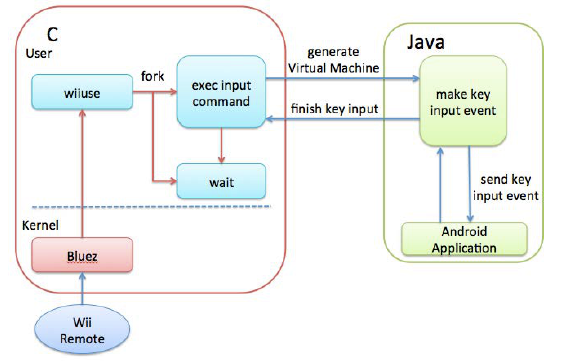
Fig. 4. use shell command